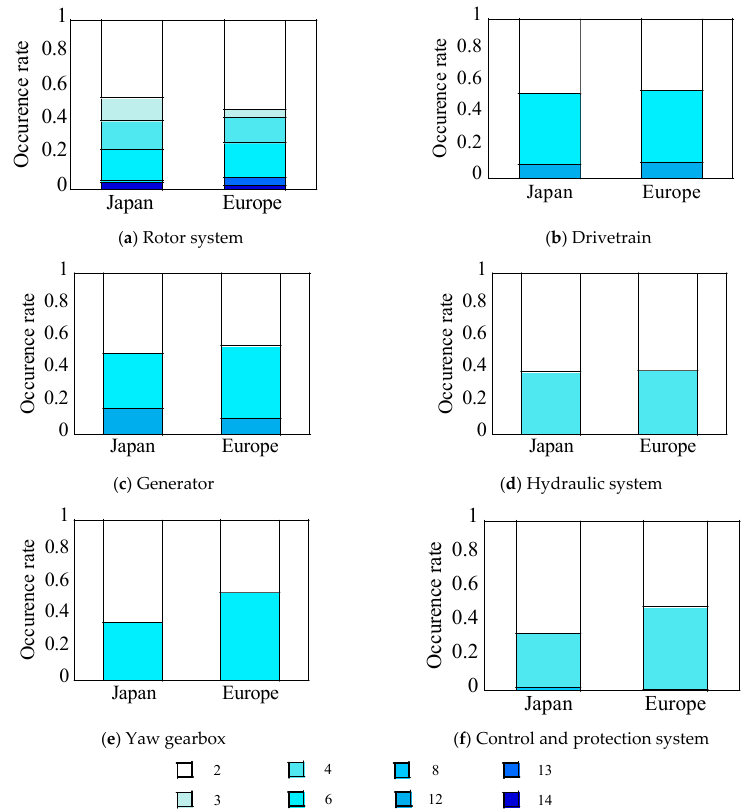
Figure 3. Comparison of FTC occurrence rate between NEDO and Reliawind databases.